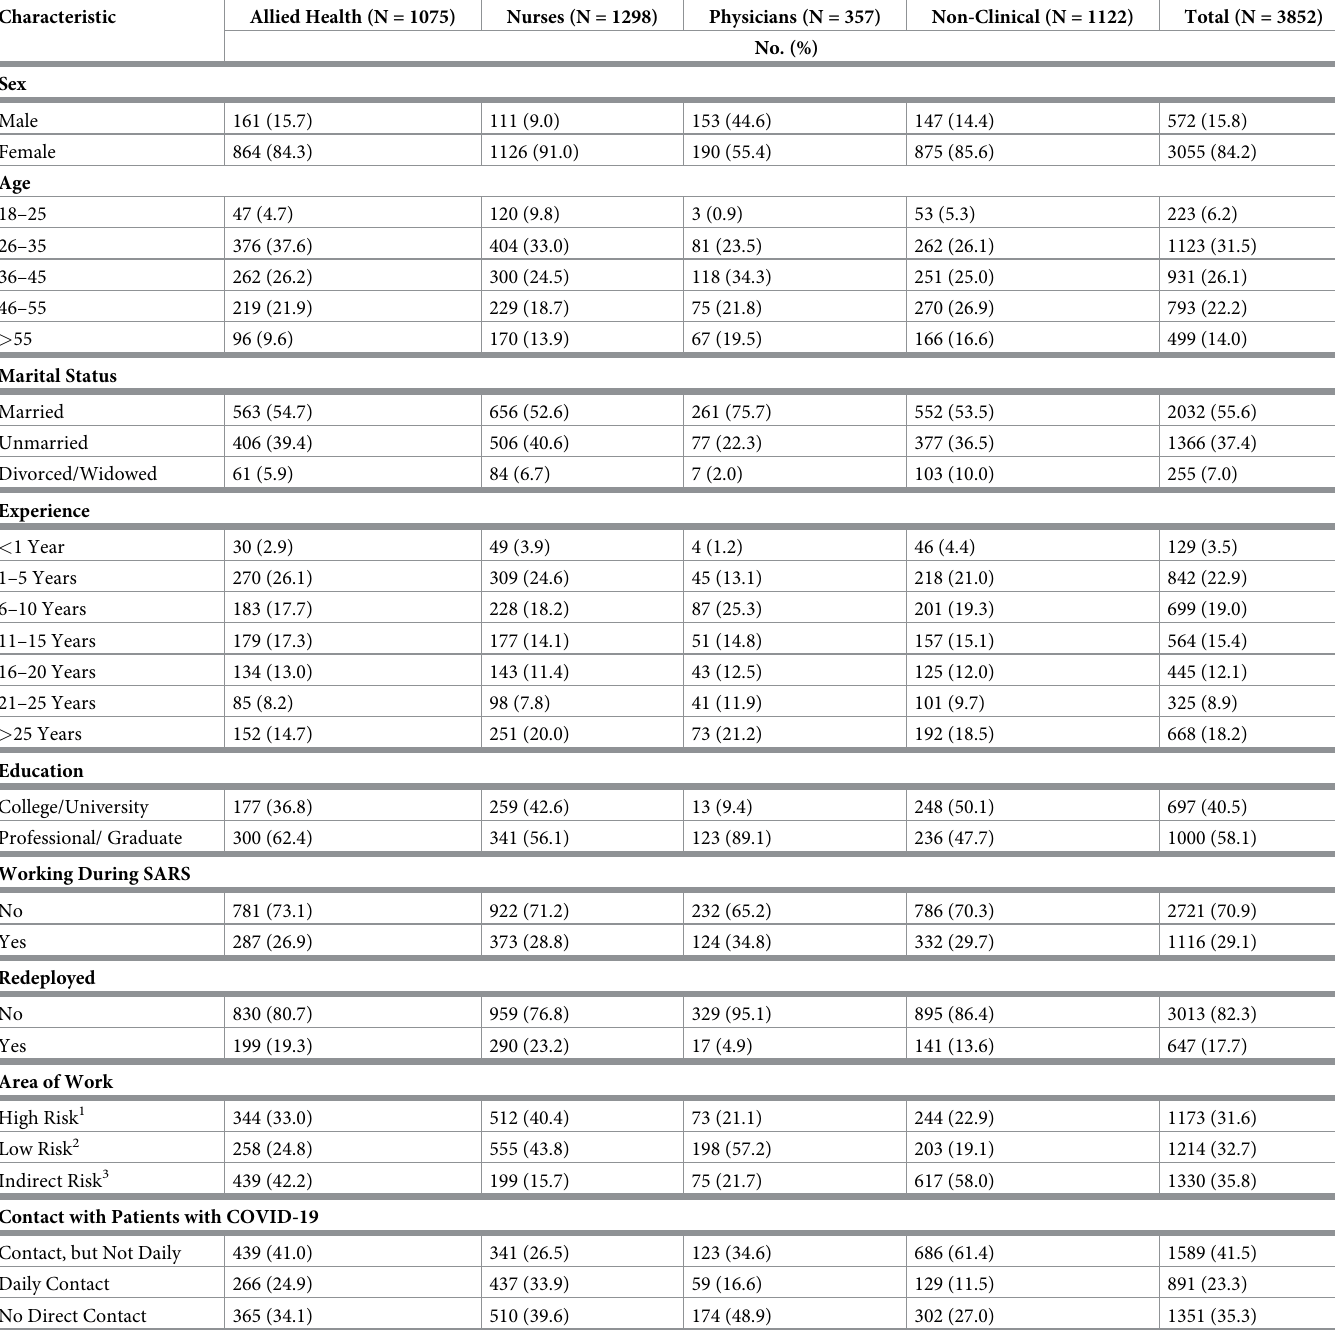
Table 1. Demographic and professional characteristics of